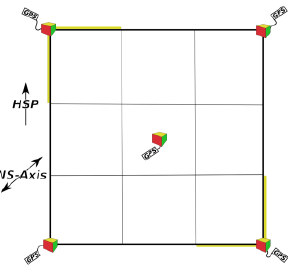
Figure 4. Schematic of plot setup with colour coded cubes and wooden rulers (yellow).